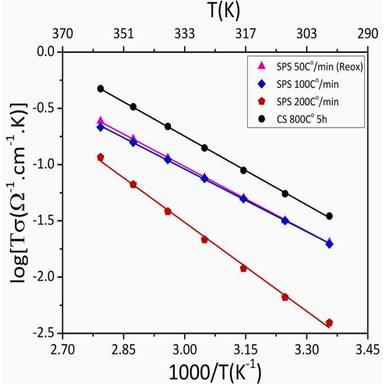
Arrhenius plot for estimation of the activation energy of samples sintered by SPS at heating rates of 50 ◦C/min to 200 ◦C/min compared to that of the one sintered by conventional method.